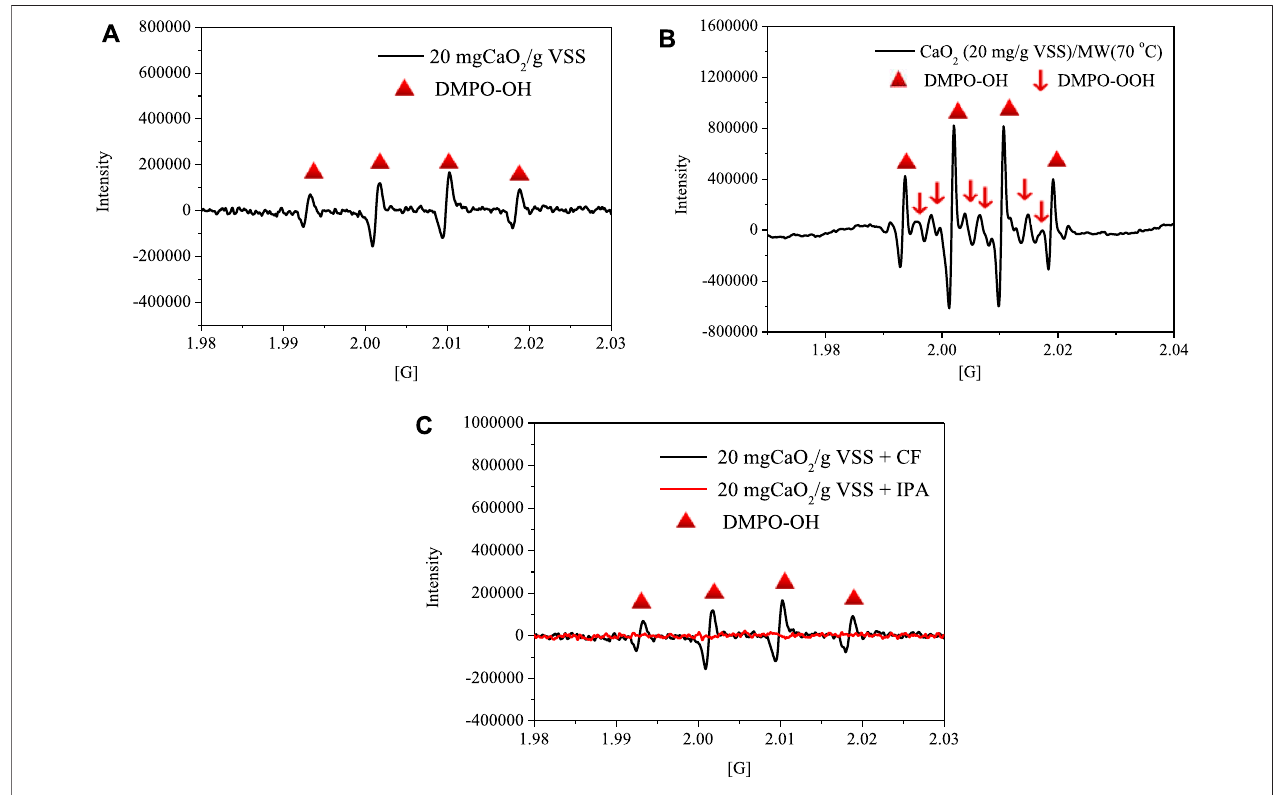
FIGURE 8 | Electron paramagnetic resonance spectra of sludge samples under different treatment